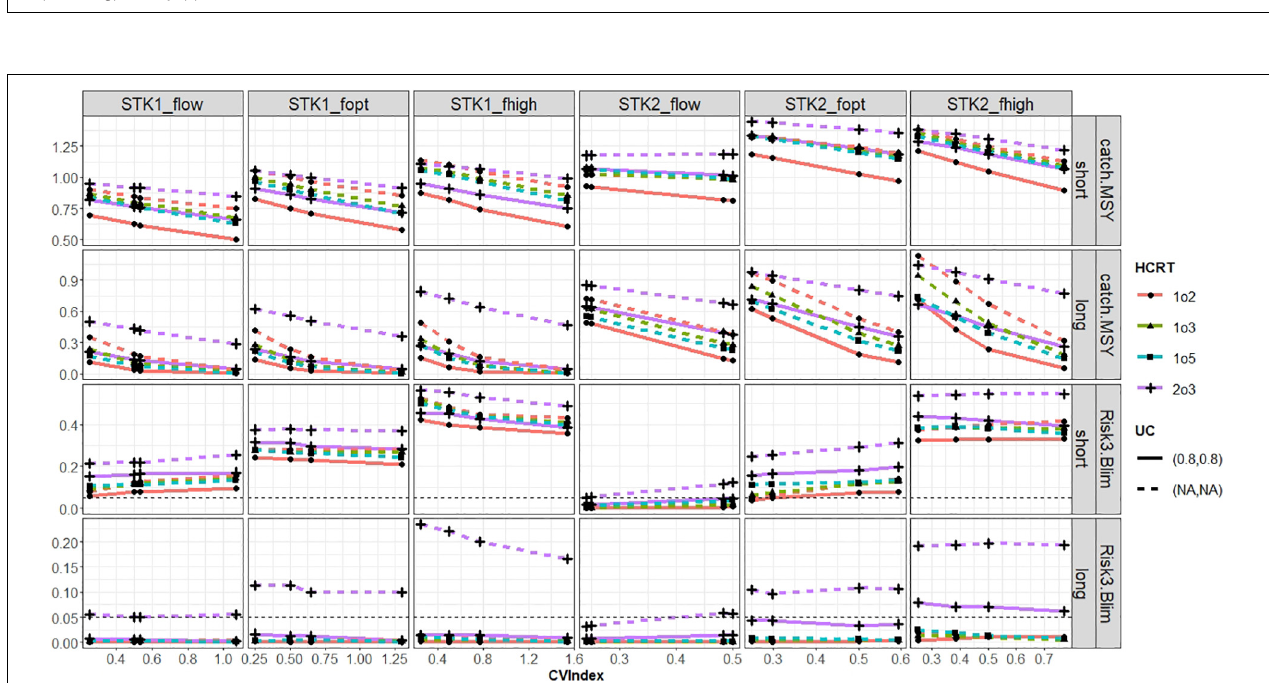
FIGURE 10 | Relative yields (catch/MSY) and biological risks (Risk3.Blim: maximum probability of falling below B lim ) in the short- and long-terms (in rows) under an in-year advice for the different CV values of the index (x-axis). The columns correspond to the operating models (combination of stock type and the historical exploitation level). The harvest control rule types are represented by the coloured lines and the uncertainty cap lower and upper limits combinations are represented by the line types (solid line: 80% symmetric uncertainty cap; and dashed line: 20% symmetric uncertainty cap). The horizontal dashed line corresponds to the 0.05 risk. See Table 1 for definitions of abbreviations. Interactive version of the figure is available online at https://aztigps.shinyapps.io/Sanchezetal2021_FMS/.